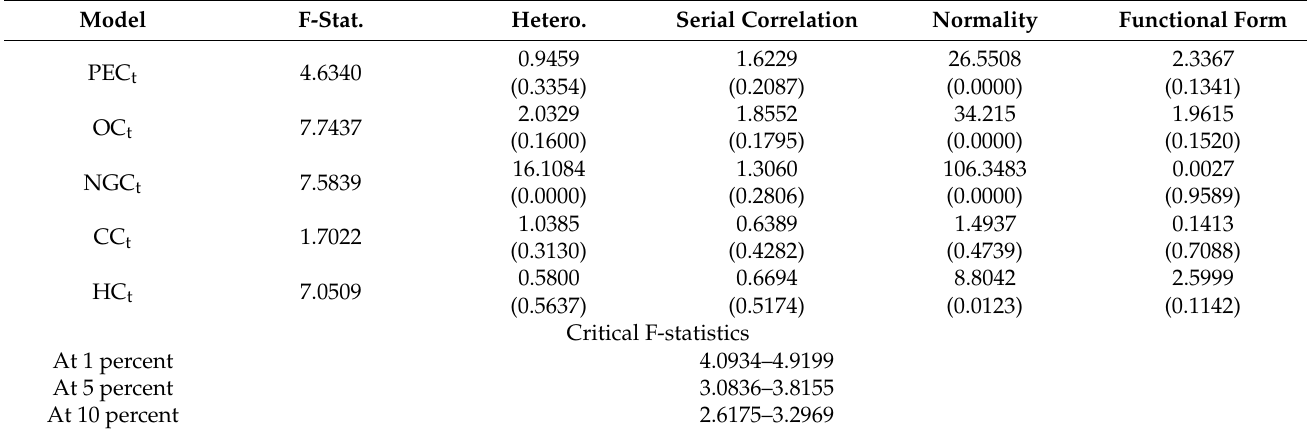
Table 3. Bound testing.